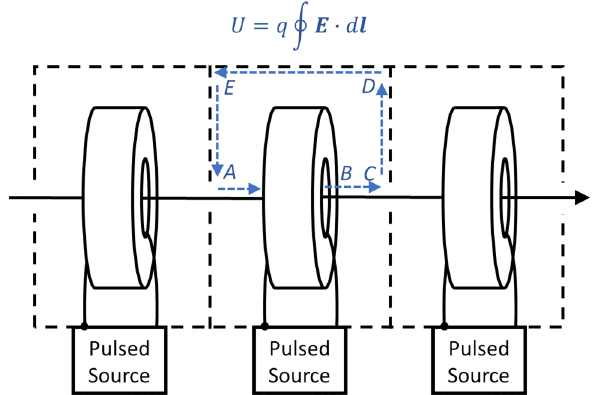
Figure 3. Acceleration of charged particles (on axis arrow) with a linear induction accelerator (LIA). Here U is the energy gain, q is the particle charge, and E is the electric field. Magnetic cores are depicted by the toroids and the dotted lines indicate conductive surfaces. One side of the pulsed source is referenced to the accelerator cavity interior (represented by the dot). The electric field outside the structure is everywhere essentially zero within the diffusion time scales of the conductive walls. Thus, the line integral is zero from segments C to A as the electric field is shorted by the conducting wall. The contribution along AB is also zero as the pulsed source output is referenced to the cavity wall. The only contribution is along line segment BC, where charge particles gain energy during the pulse. N cavities are arranged in series to provide a total acceleration of NV pulsed source